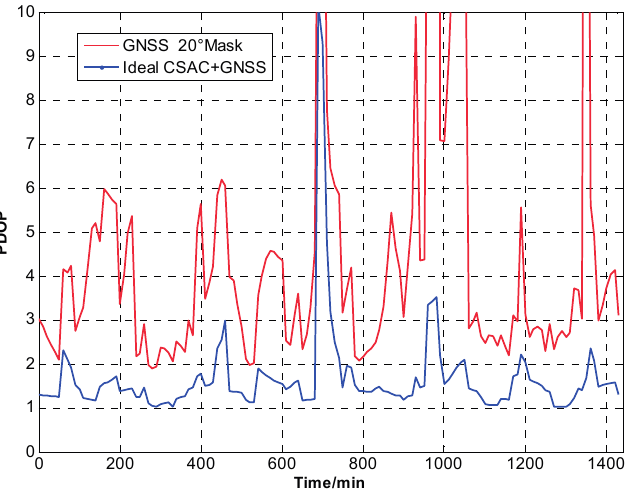
Figure 10. VDOP comparison at 10° cutoff.